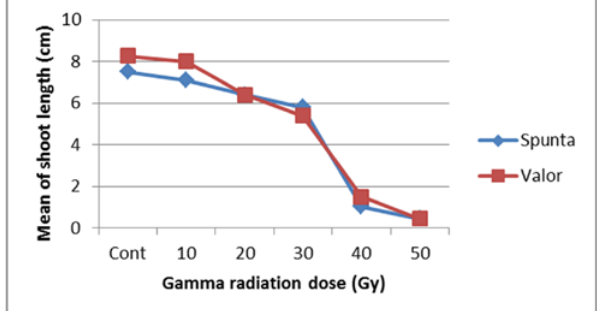
Fig. 1. Gamma radiation impact on potato bud survival percentage cvs. ‘Spunta’ and ‘Valor’